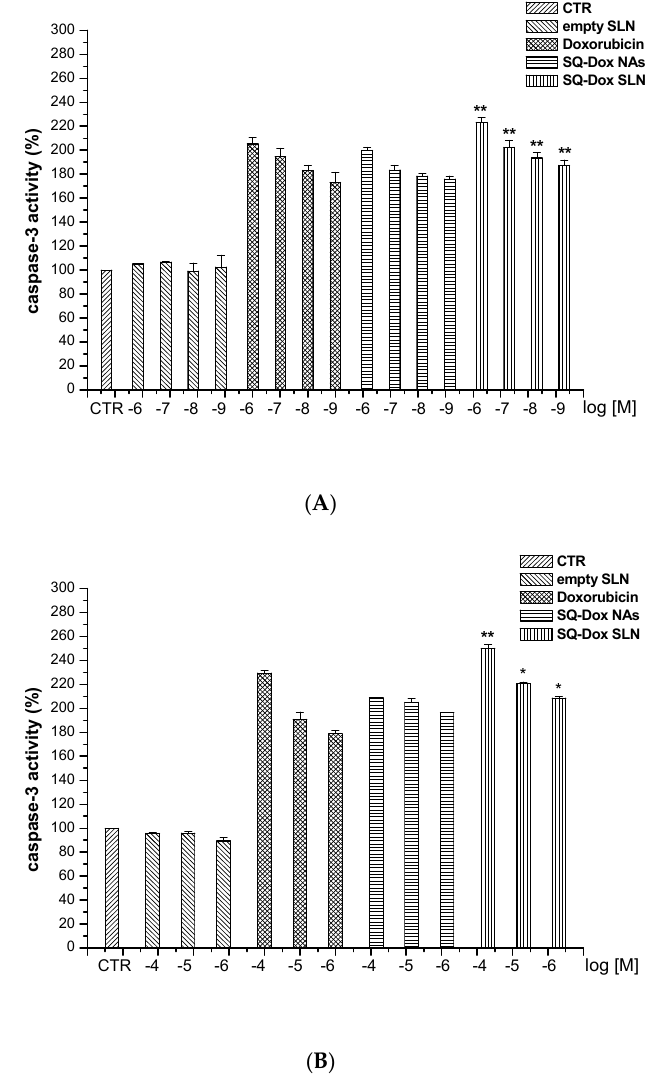
Figure 5. Levels of caspase-3 activity after Dox, SQ-Dox NAs and SQ-Dox SLN1 treatment. Caspase-3 activity was evaluated in A2780 ( A ) and A2780 res ( B ) cell lines cultured for 72 h in either the presence or absence of Dox, SQ-Dox NAs, SQ-Dox SLN1 or empty SLNs. Results are expressed as % of relative caspase activity, calculated as follows: (result displayed by each treatment/result displayed by untreated cells). * p < 0.05 and ** p < 0.01, vs. Dox-treated cells at the same concentrations, from three independent experiments.